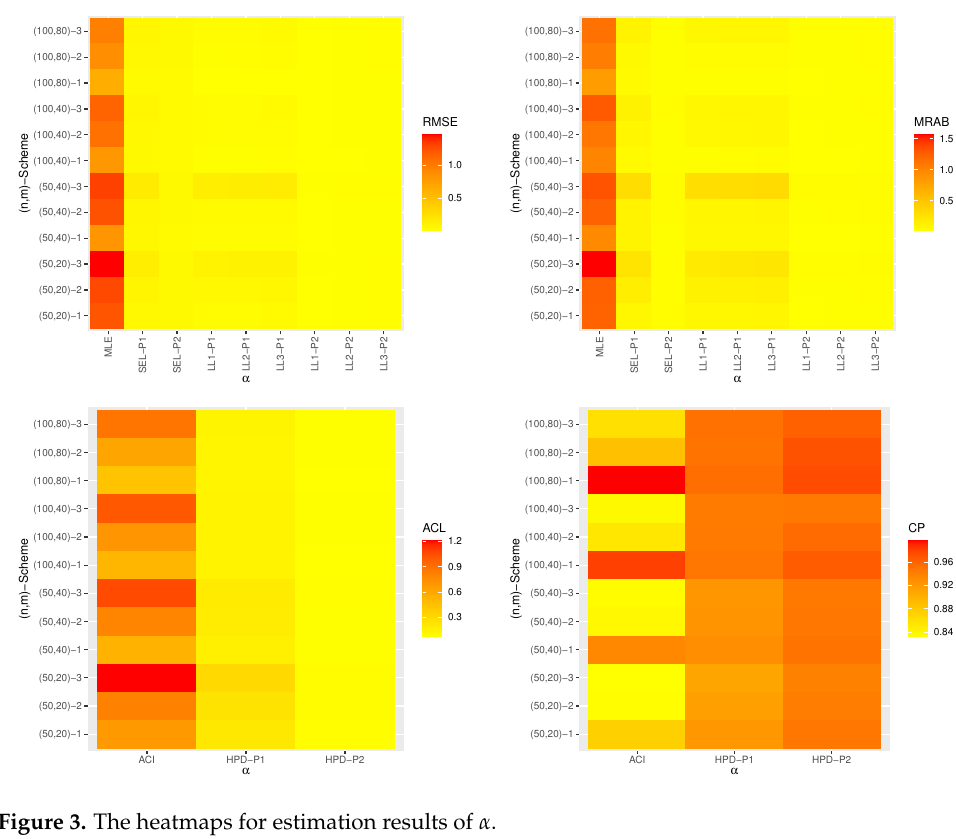
Figure 3. The heatmaps for estimation results of α .